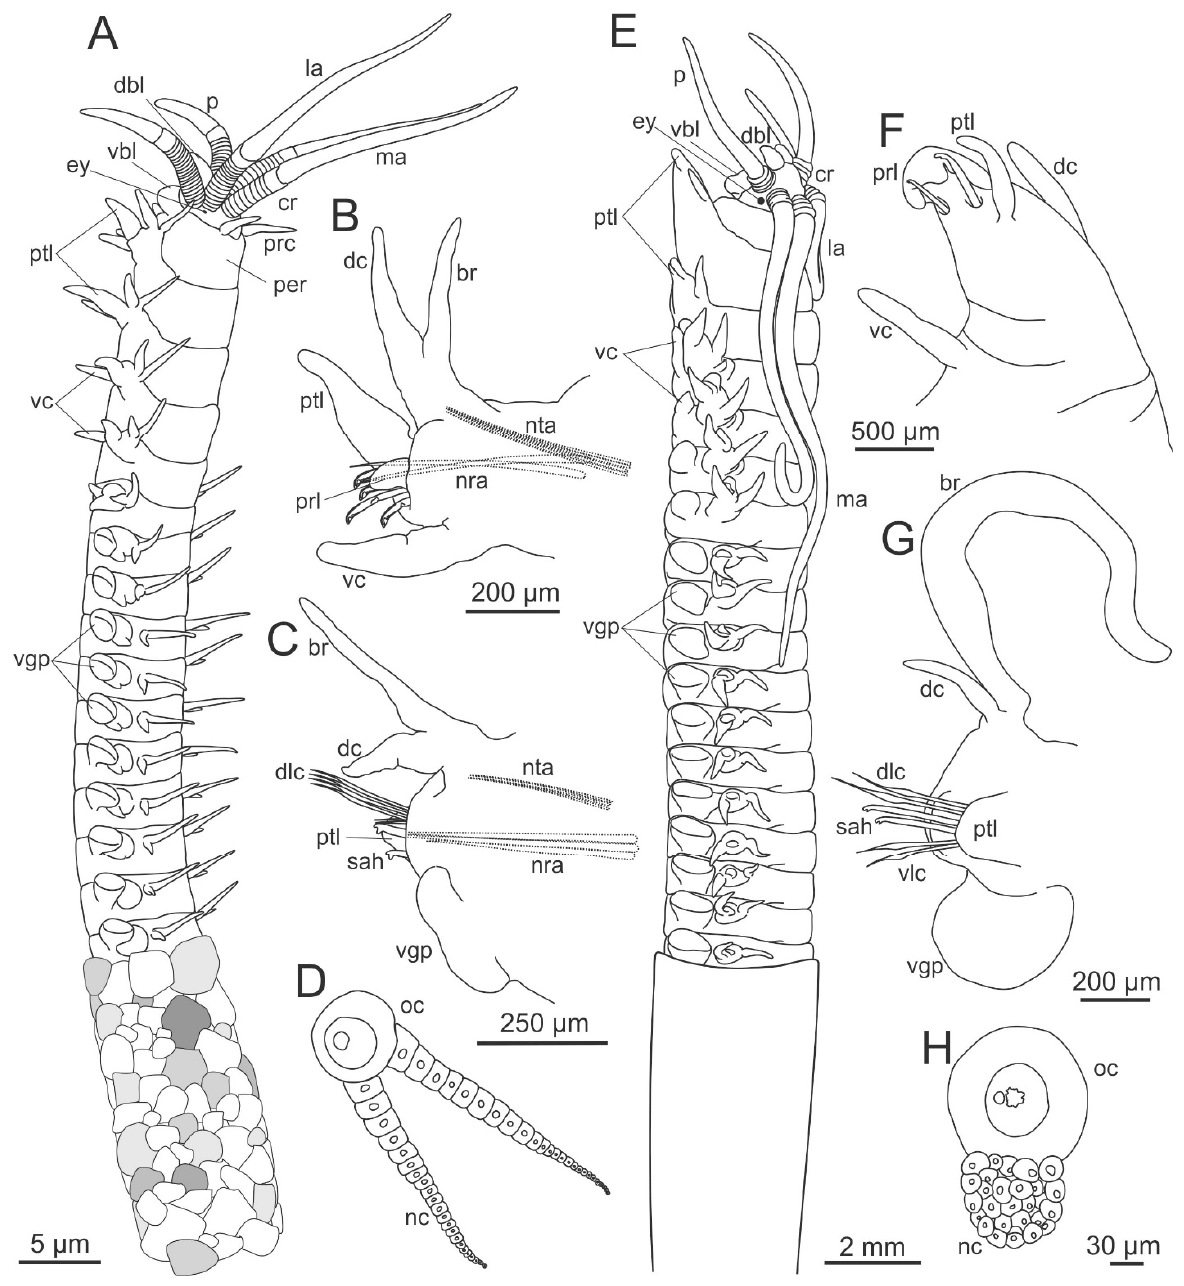
Figure 10. Morphology of Onuphidae. ( A ) Onuphis sp. (Onuphinae), anterior end, lateral view; ( B ) the same, anterior modified parapodium; ( C ) the same, posterior parapodium; ( D ) Onuphinae, oocyte; ( E ) Hyalinoecia sp. (Hyalinoeciinae), anterior end, lateral view; ( F ) the same, anterior modified parapodium, aciculae not shown; ( G ) the same, posterior parapodium, aciculae not shown; ( H ) Leptoecia vivipara Orensanz, 1990, oocyte. br–branchia, cr–ceratophore, dbl–dorsal buccal lip, dc–dorsal cirrus, dlc–dorsal limbate chaetae, ey–eye, la–lateral antenna, ma–median antenna, nc–nurse cells, nra–neuroaciculae, nta–notoaciculae, oc–oocyte, p, palp, per–peristomium, prc–peristomial cirrus, prl–prechaetal lobe, ptl–postchaetal lobe, sah–subacicular hook, vbl–ventral buccal lip, vc–ventral cirrus, vgp–ventral glandular pad, vlc–ventral limbate chaetae.